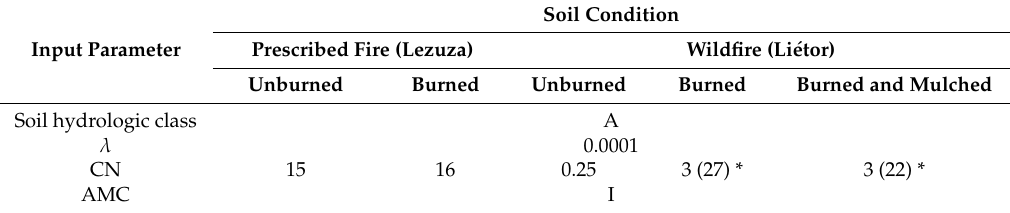
Table 3. Optimal values of the Soil Conservation Service-curve number (SCS-CN) model parameters used for runo ff predictions in plots subject to prescribed fire and wildfire (Lezuza and Li é tor, Castilla La Mancha,